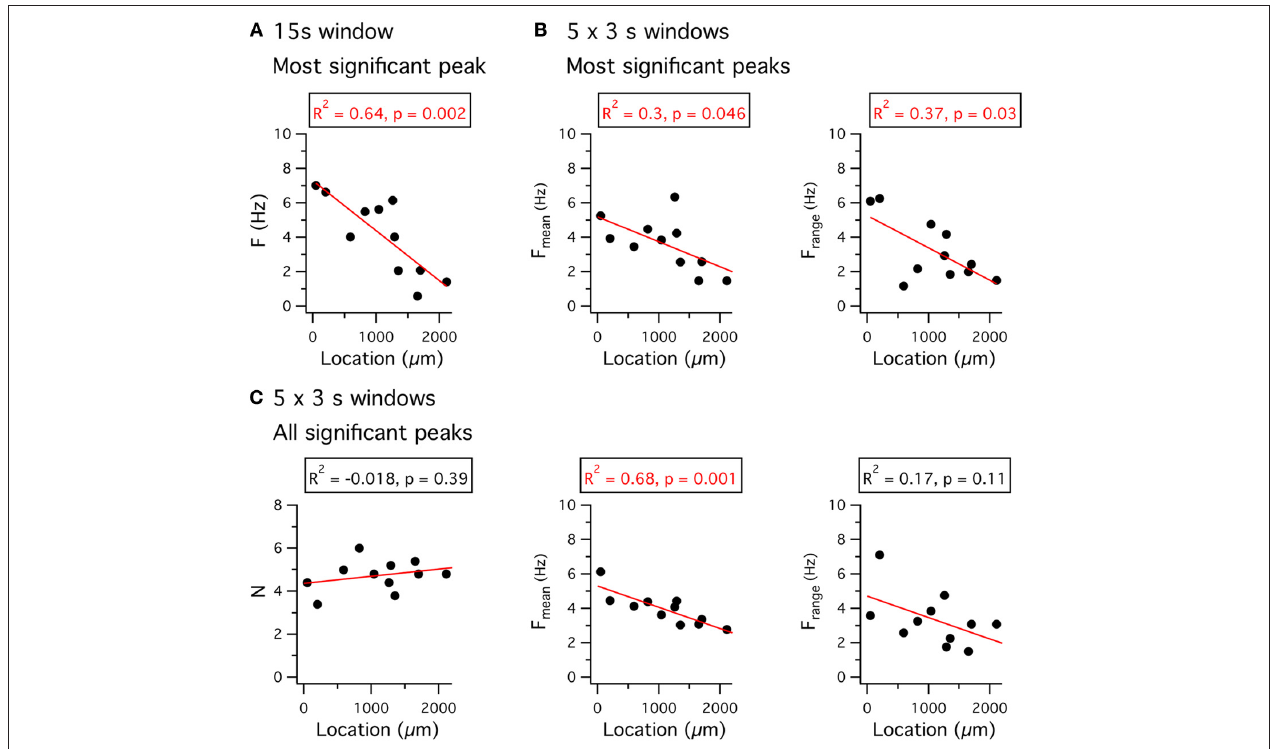
(left), the mean frequency (middle) of all significant peaks, and the range of frequencies of all significant peaks (right), obtained from five consecutive 3s duration segments of peri-threshold activity, plotted as a function of the location of the recorded neuron. Data analyzed were from 5s to 20s after the onset of the largest amplitude current step that did not trigger action potential firing. Adjusted R 2 value and significance of the fit for the perforated patch-clamp data are stated above each plot. Location refers to distance from the dorsal border of the MEC.